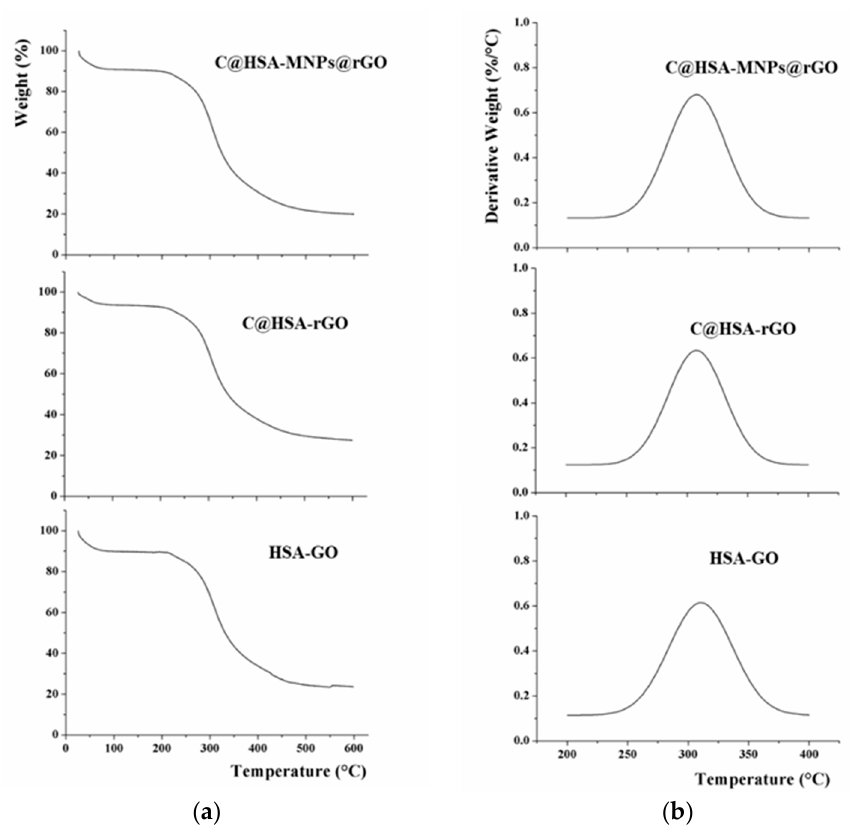
Figure 5. TGA ( a ) and DTG ( b ) curves of C@HSA-rGO, HSA-GO, and C@HSA-MNPs@rGO.